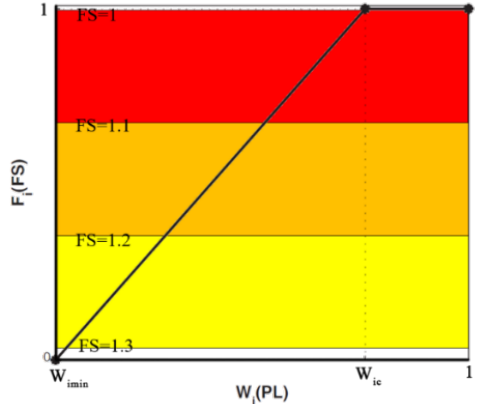
Figure 3. Schematic diagram of vulnerability curve.